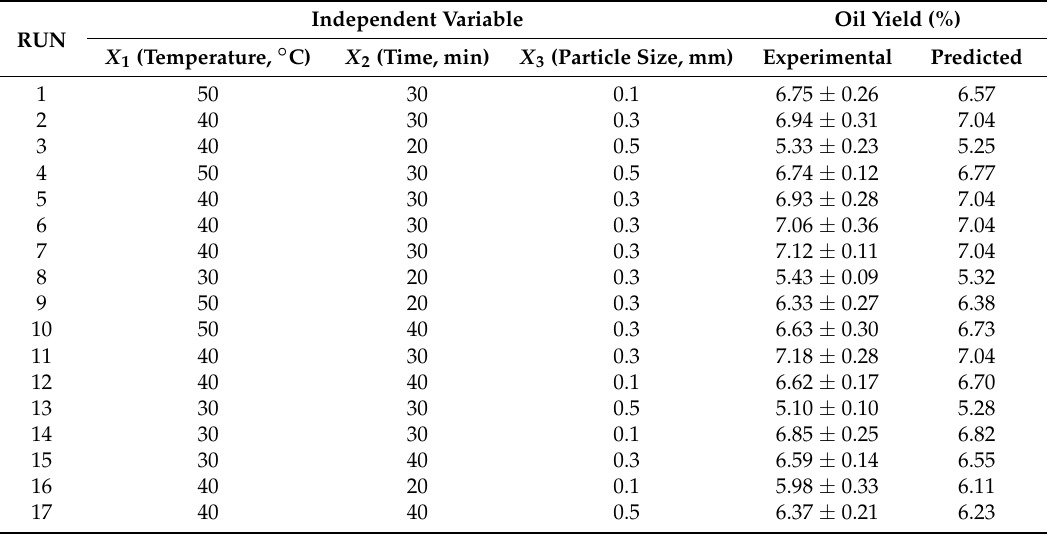
Table 4. Box-Behnken design (BBD) matrix and the response values for the oil yield of fenugreek seed. Independent Variable Oil Yield RUN